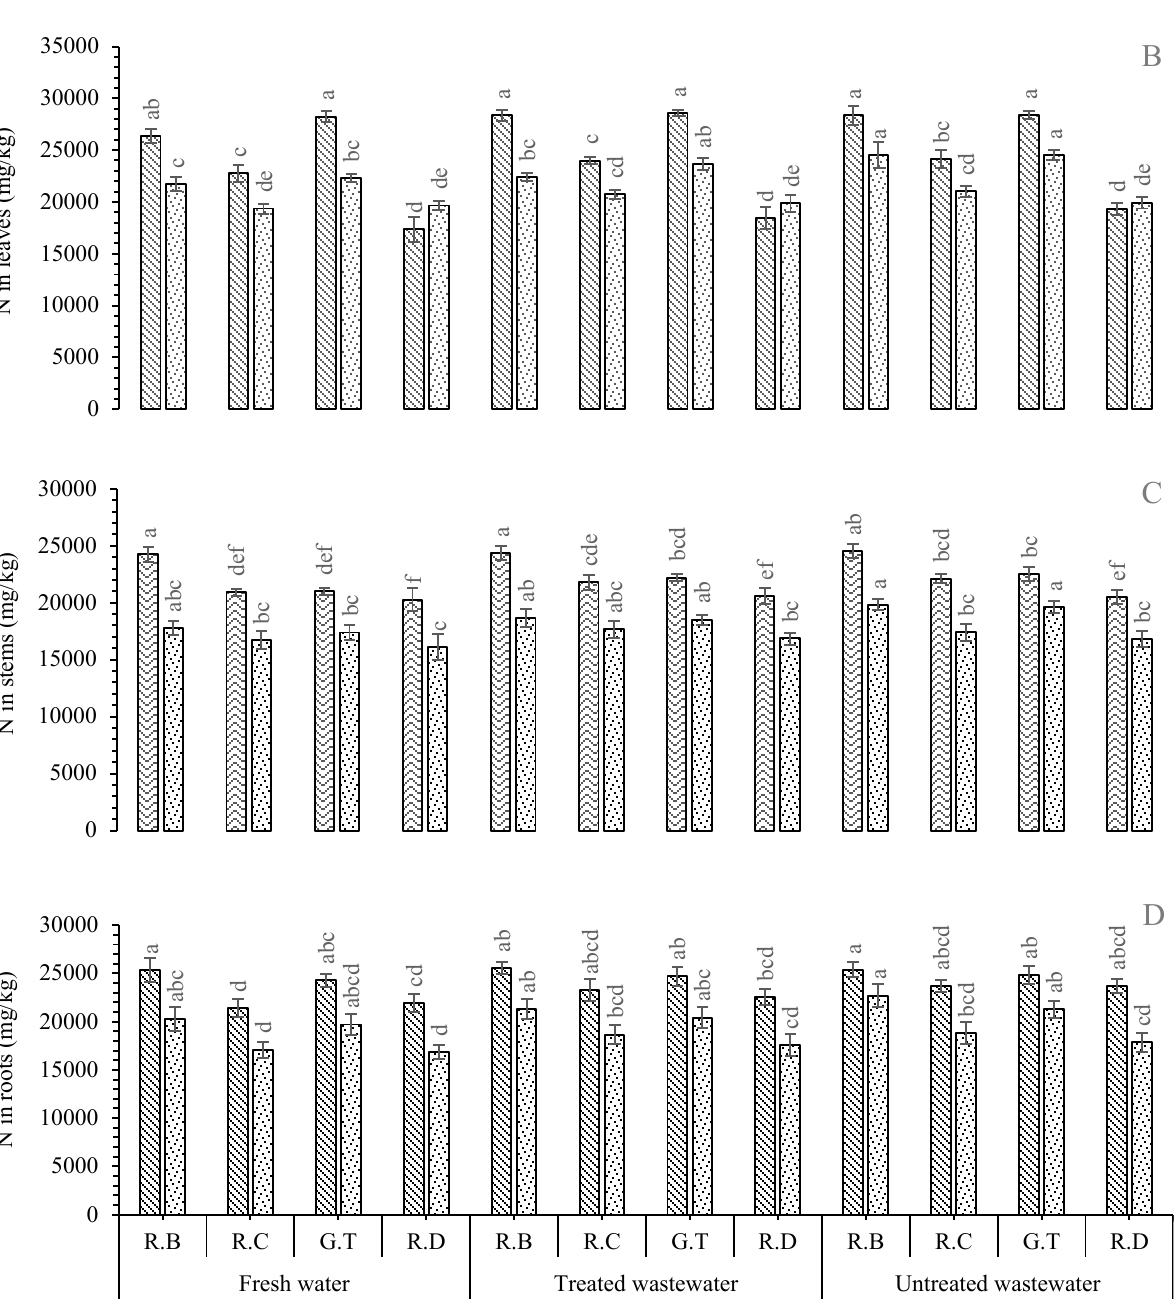
Figure 1. Mean concentration of N in plant parts, i.e., flowers ( A ), leaves ( B ), stems ( C ), and roots ( D ) of Rosa species under different irrigations. Each vertical bar represents the average of three replicates. Different letters indicate significant differences among treatments at p ≤ 0.05 according to least significant difference test. R.B: Rosa bourboniana , R.C: Rosa centifolia , G.T: Gruss-an-teplitz, R.D: Rosa damascena.